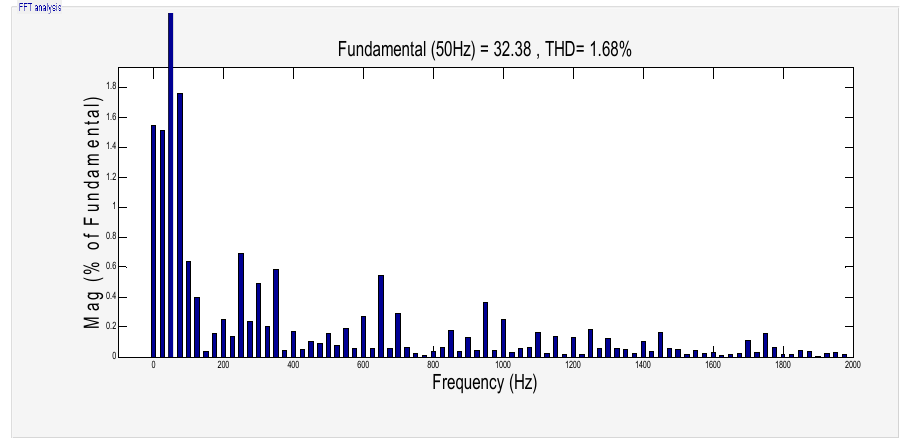
Figure 9. Harmonic spectrum of the source current at 0.06 s.